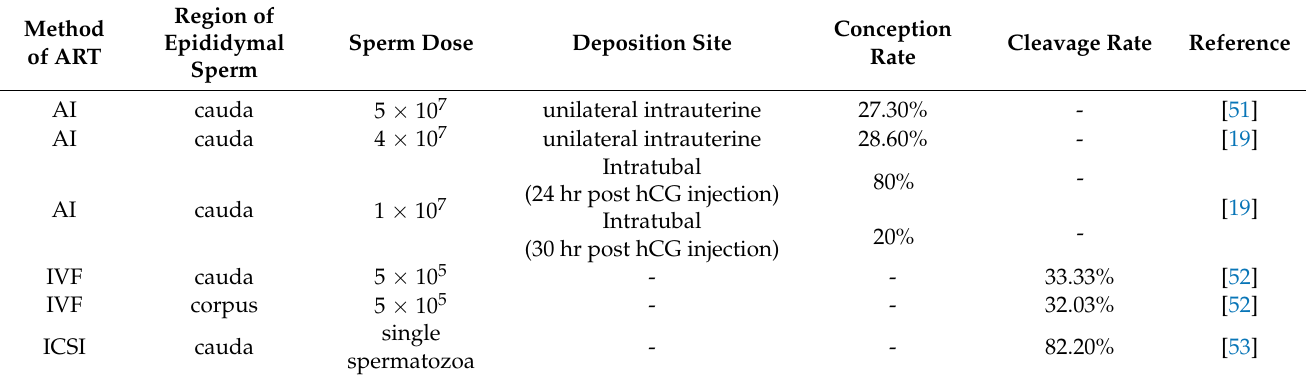
Table 3. Application of ART in the domestic cat using frozen–thawed epididymal